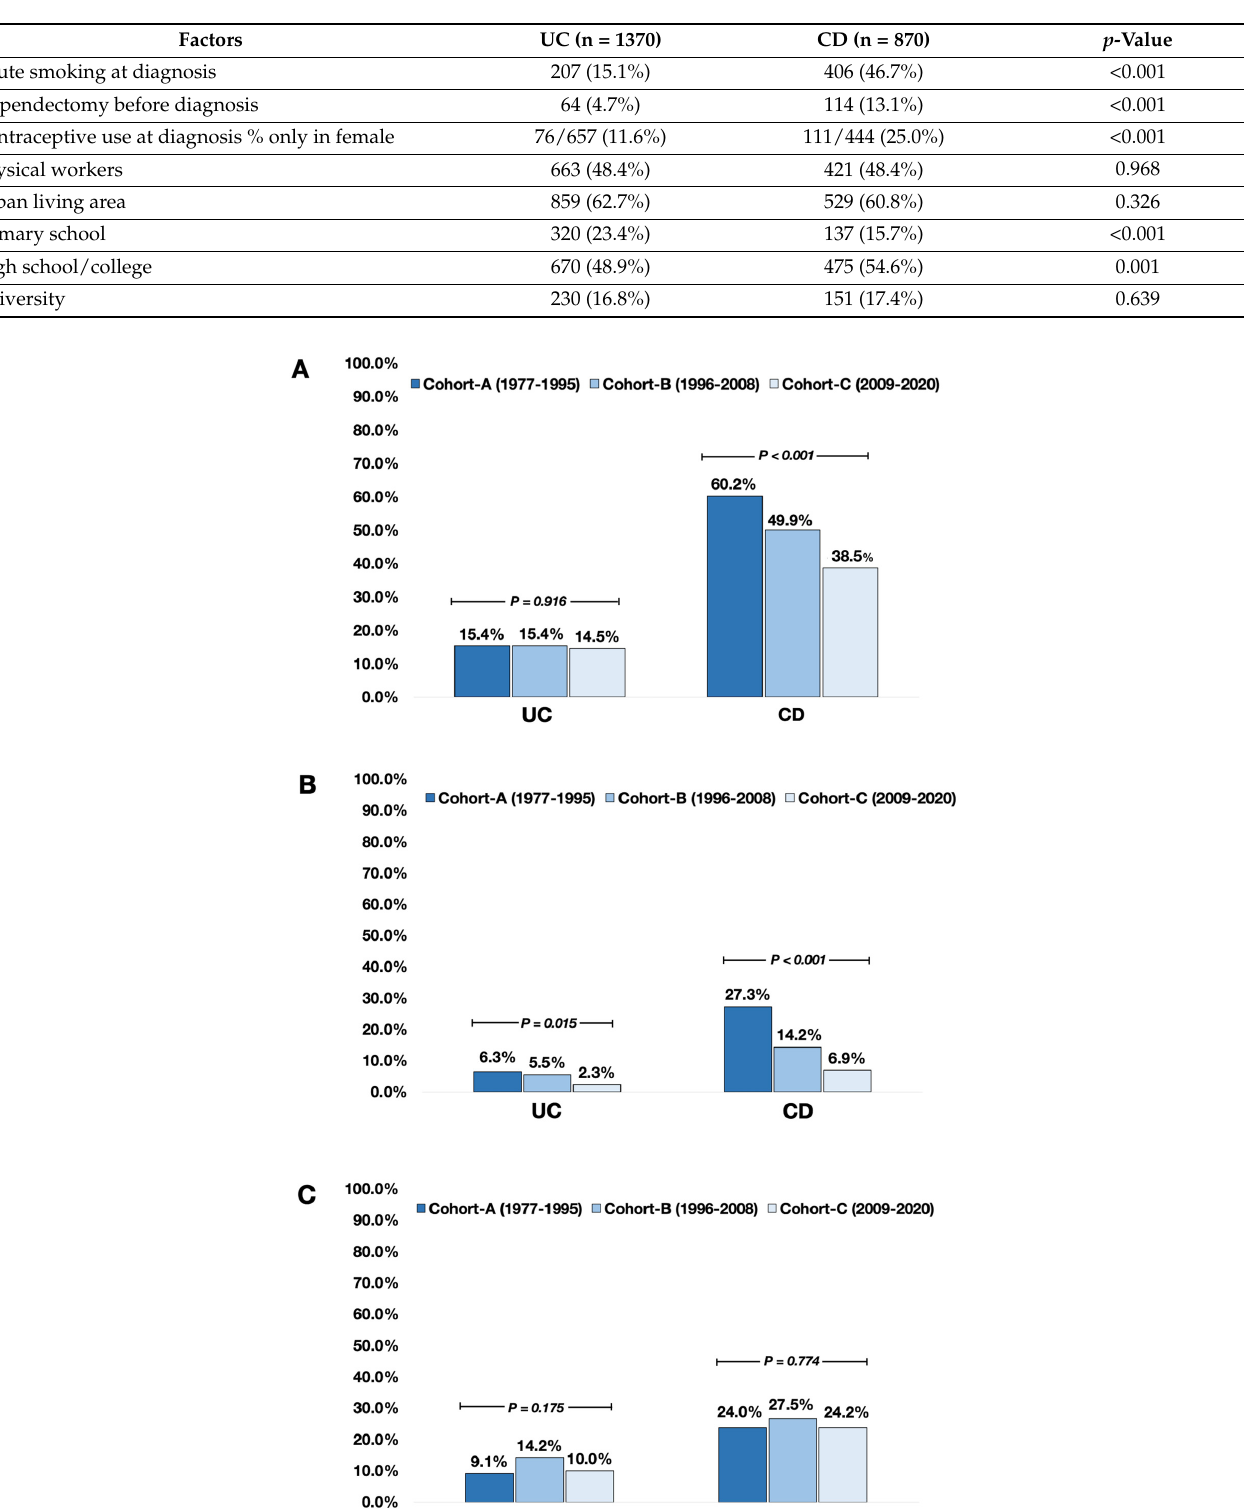
Table 4. Differences in environmental and socio-economic factors between the incident UC and CD patients stratified by the eras of diagnosis.